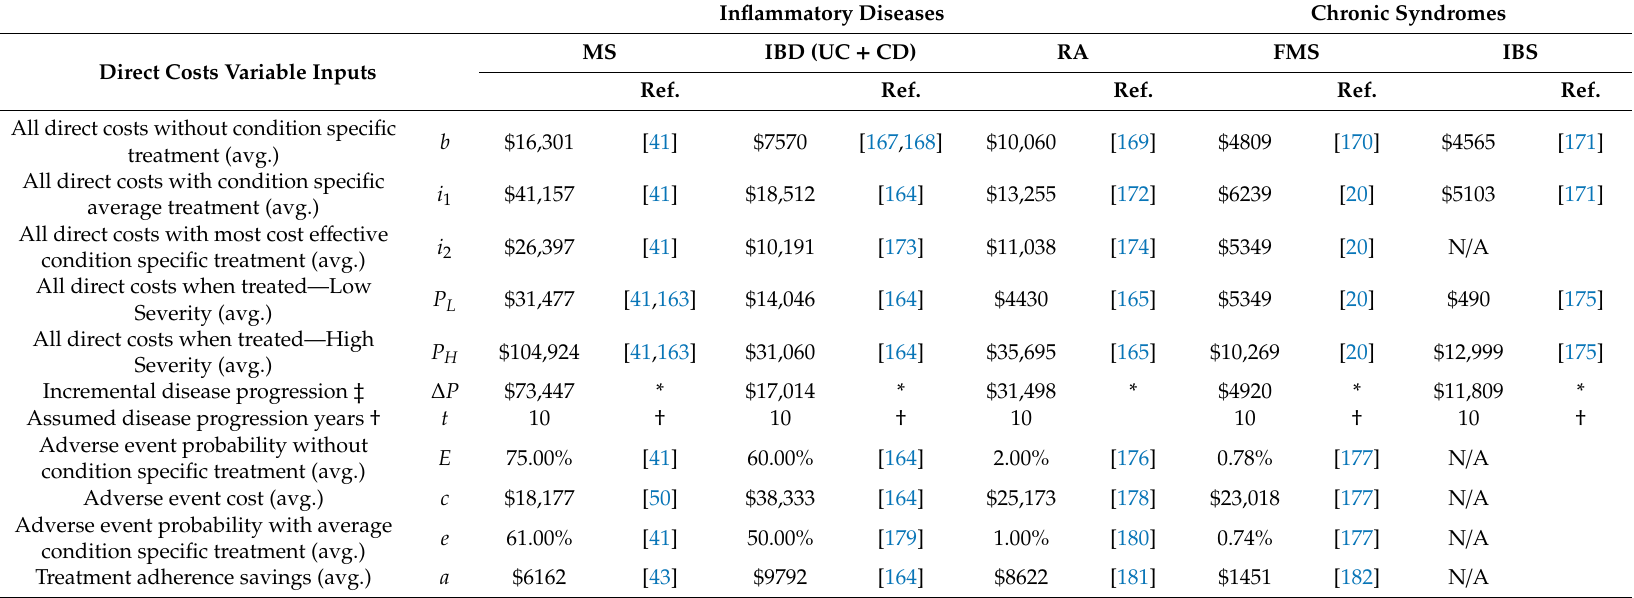
Table 2. Direct costs inputs to financial analysis